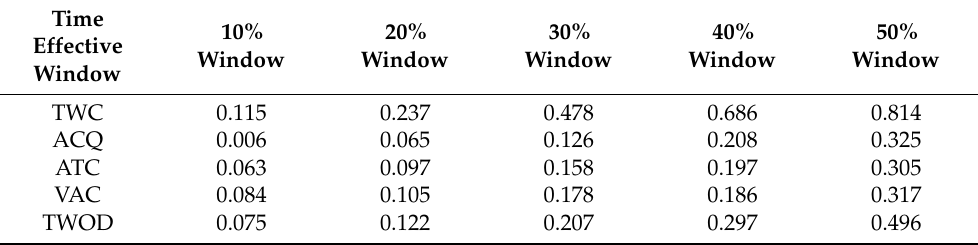
Table 3. The distribution proportion of community attributes in different time windows of q